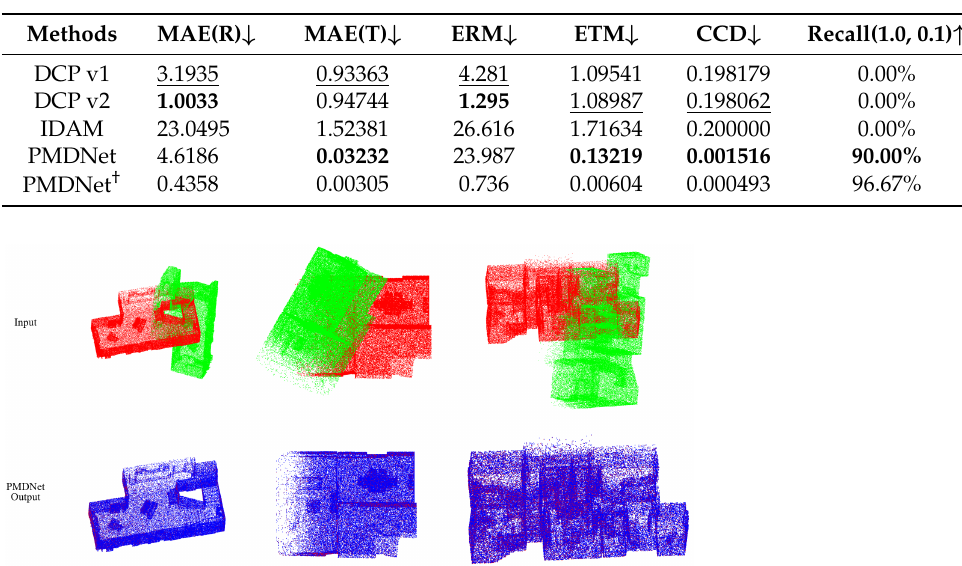
Table 11. Results on noise density-decreasing BIM scenarios. Bold and underline denote best and second best performance, respectively. PMDNet fails on three scenarios, contributing to large MAE ( R ) and ERM , but achieves great performance on all the other samples. PMDNet † shows the metrics on successfully predicted scenarios.